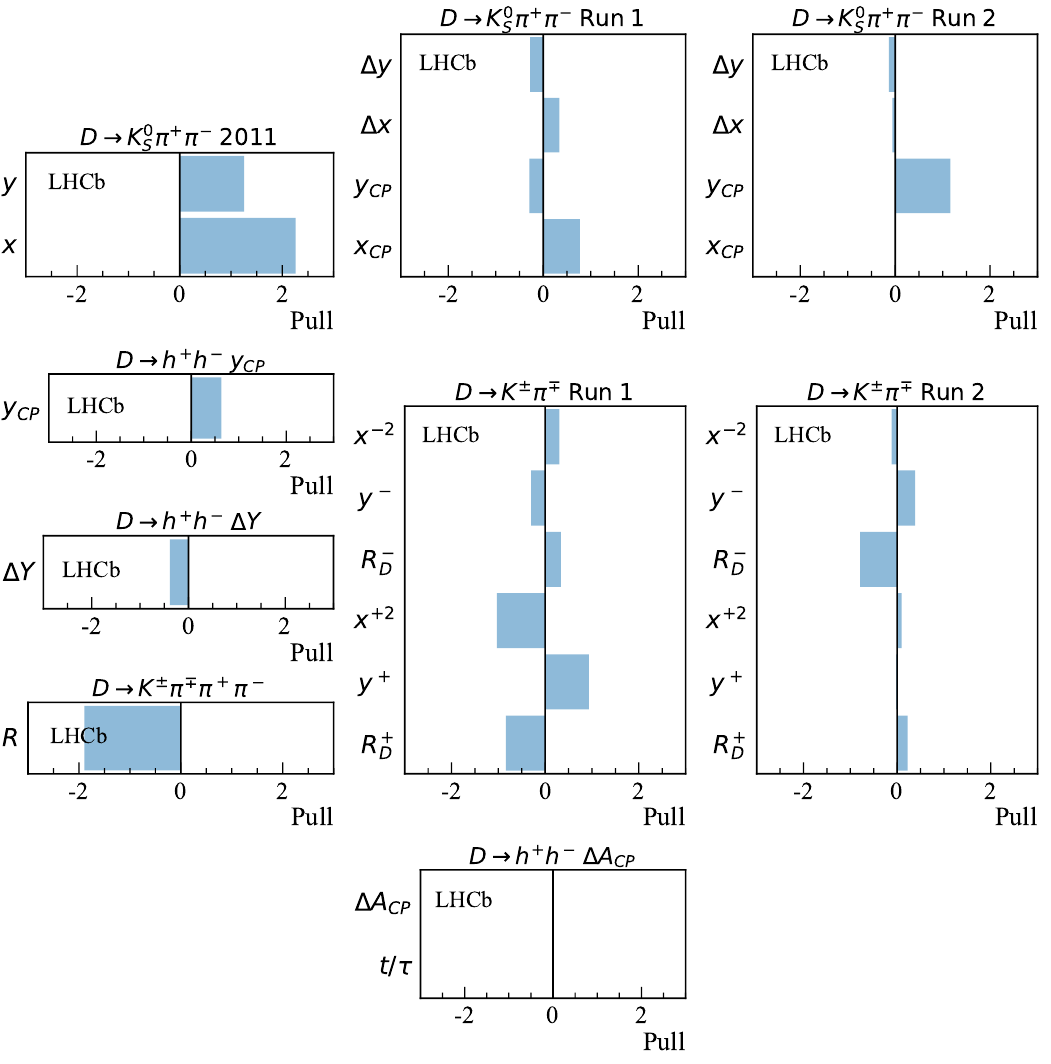
Figure 8 . Pulls of the input observables, part 3 of